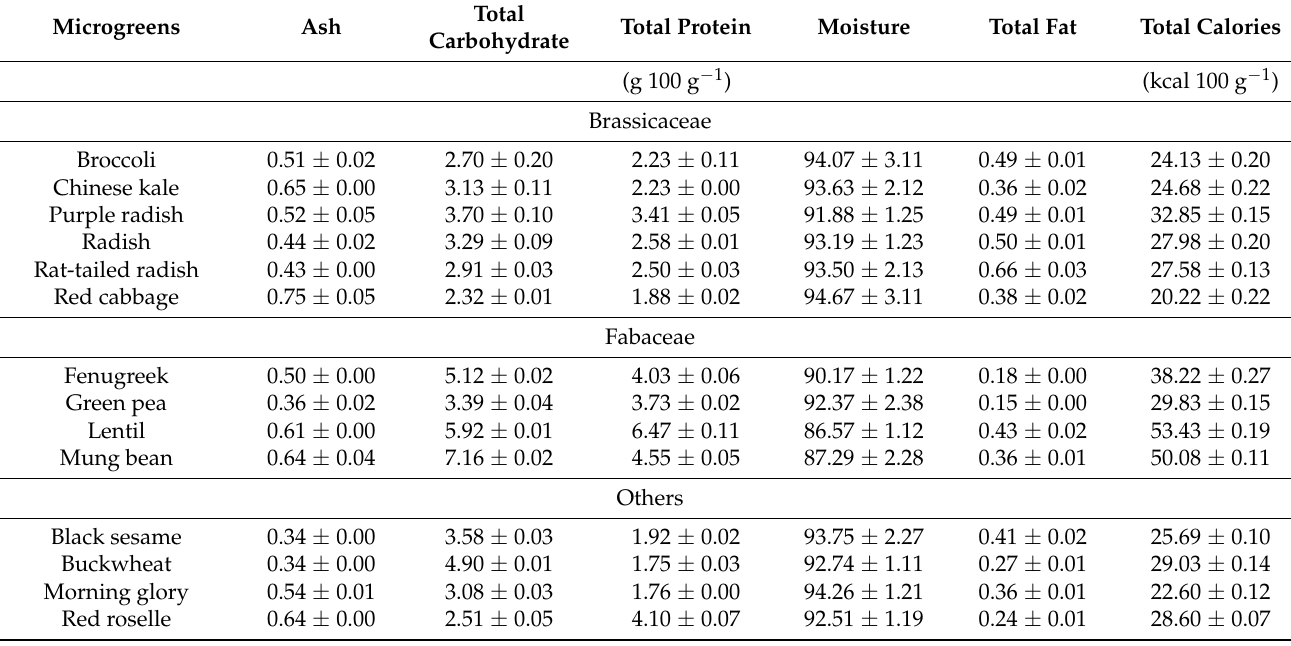
Table 3. Proximate analysis of the studied microgreens grown under controlled